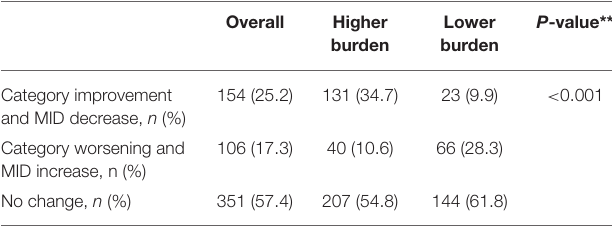
TABLE 1 | Change in CAT burden category a and MID change over 6 months using a Chi-square test.